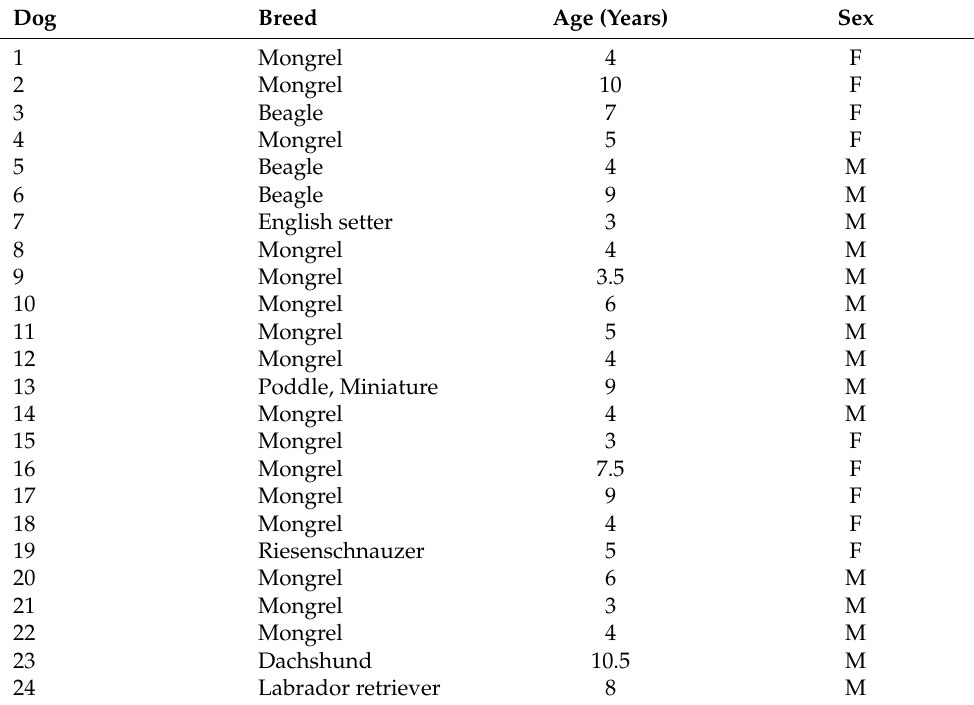
Table 1. The table reports the data (age, sex, weight) of the belonging to the control group. Dog Breed Age